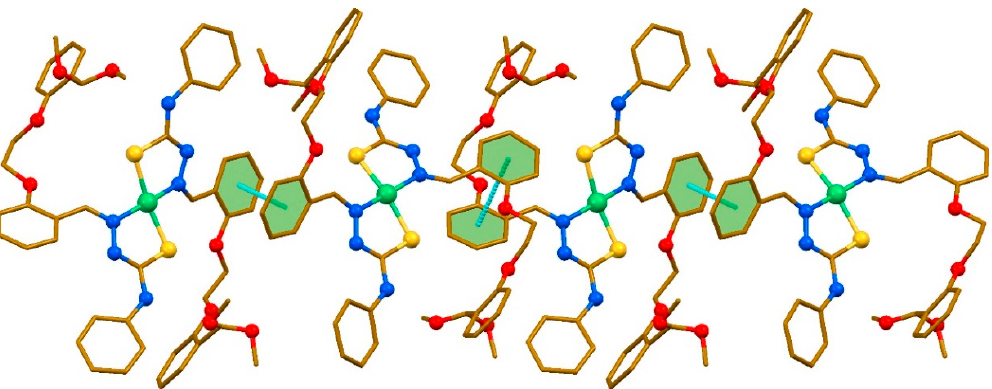
Figure 5. 1D polymeric chain, formed along the c axis by π ⋯ π stacking interactions in the crystal structure of 2 (hydrogen atoms are omitted for clarity). Color code: C = gold, H = black, N = blue, O = red, S = yellow, Ni = green; π ⋯ π stacking interaction = cyan dashed line.